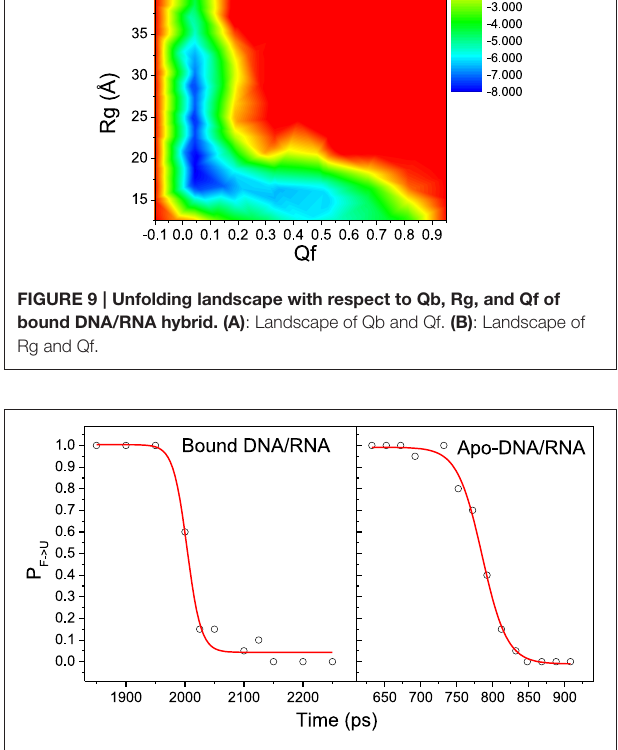
FIGURE 10 | A representative transition probability P calculated at 498 K for the F ⇔ U transition for snapshot in the transition region for one of the trajectories of bound and apo-DNA/RNA hybrid, respectively. The red line is the fit to P = 1 /{1 + exp [( τ - τ TS )/ τ trans ]}.